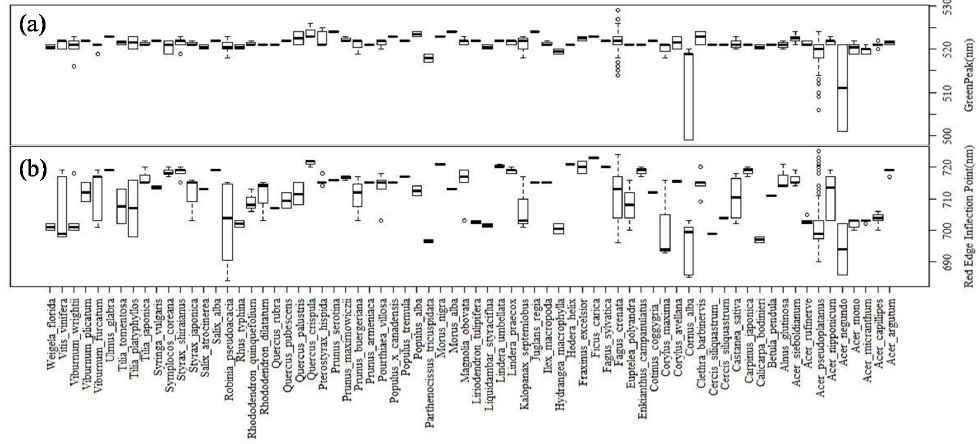
Figure 11. ( a ) Green peak and ( b ) red edge positions for deciduous species considered in this study.